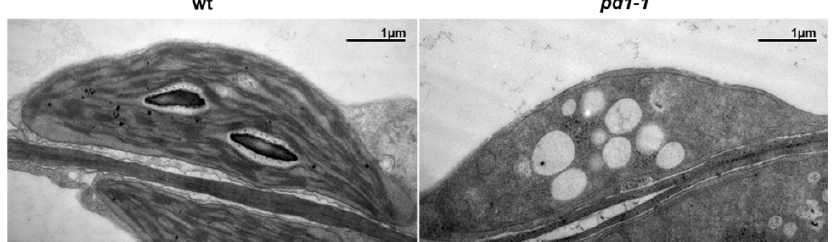
Figure 2. Transmission electron microscopic images of chloroplasts in leaves from two-week-old wild type and pd1-1 mutant seedlings grown on MS medium with 3% sucrose. Bars = 1 μ m.